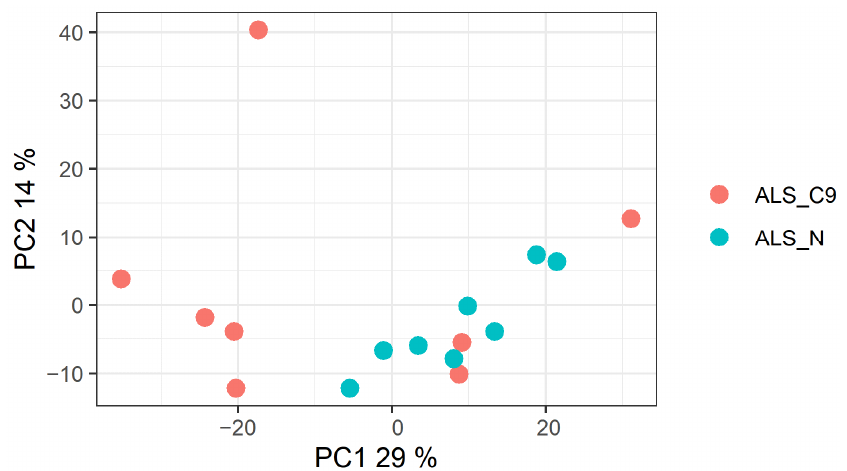
Figure 2. PCA comparing ALS_C9 and ALS_N patients’ proteome. The PCA analysis was performed considering all quantified proteins in fibroblasts from patients included in the two groups ( n = 16). Each dot represents a patient. Pink: ALS_C9. Light blue: ALS_N.